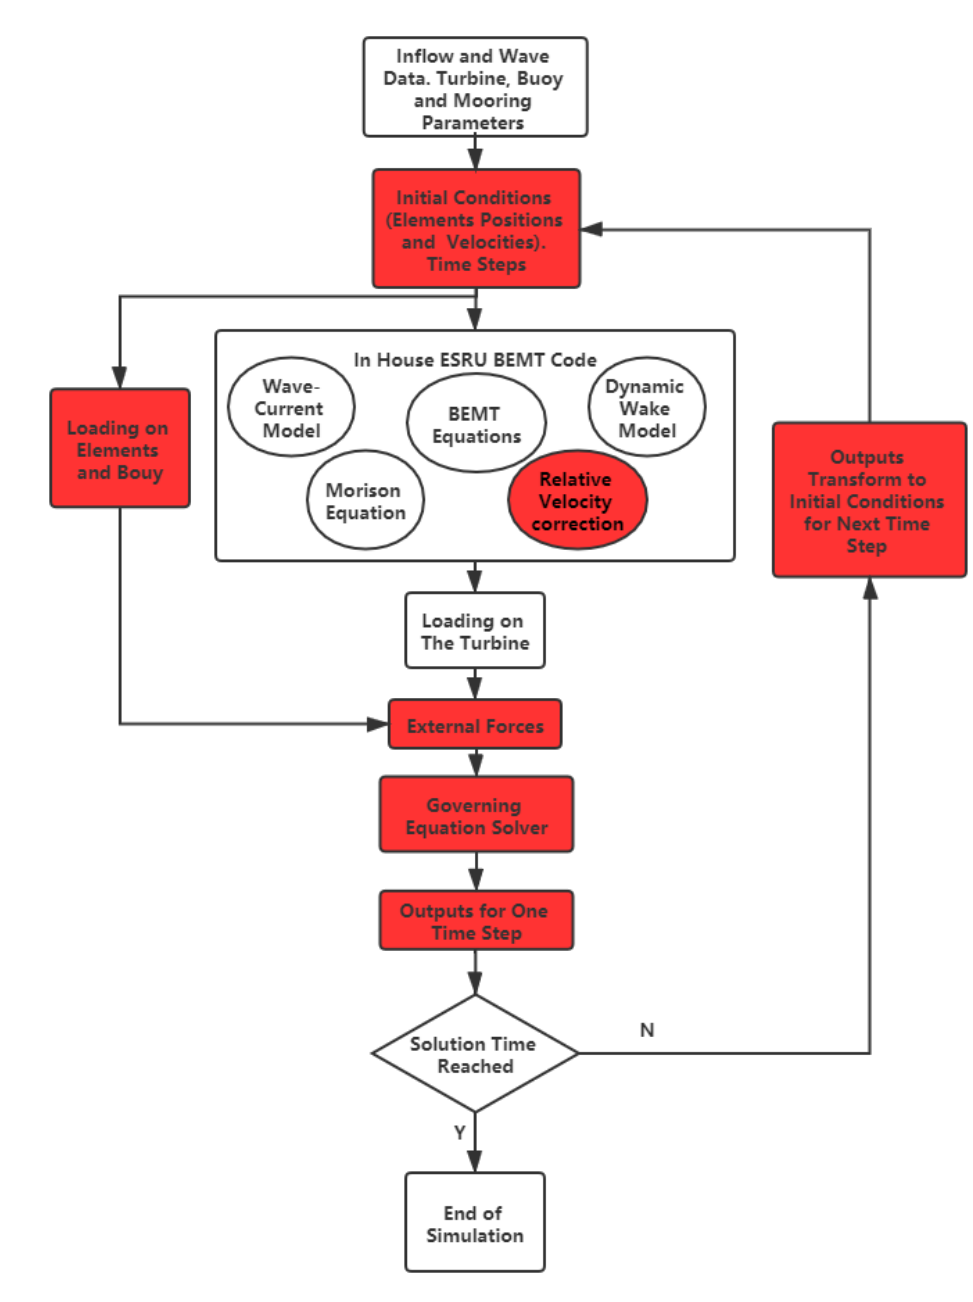
Figure 5. Solution